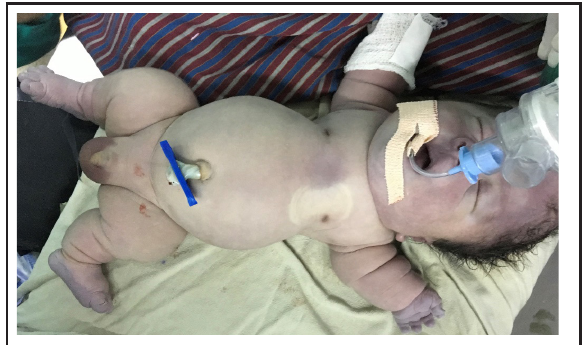
Figure 2. Showing micromelia, macrocephaly, narrow thorax, and protruding abdomen.